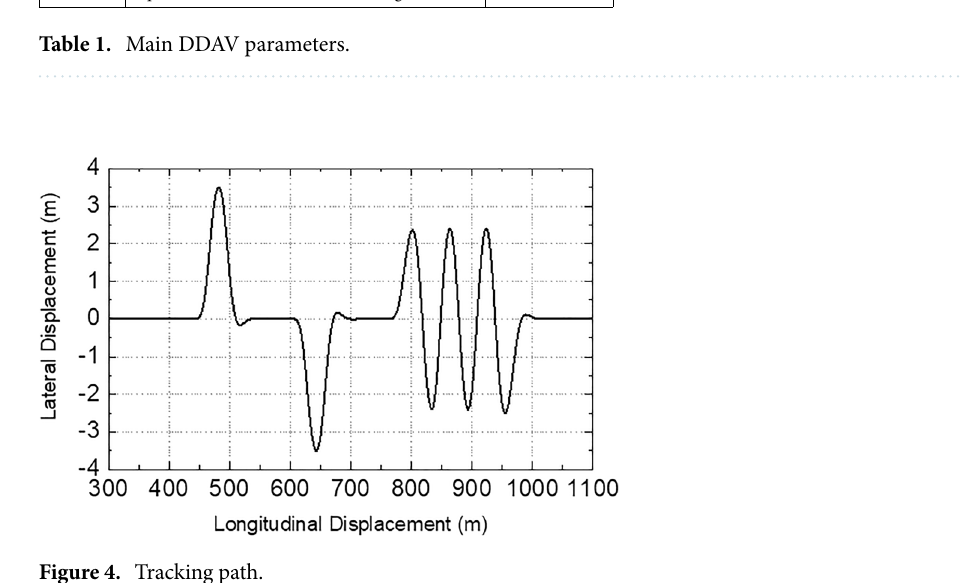
Figure 4. Tracking